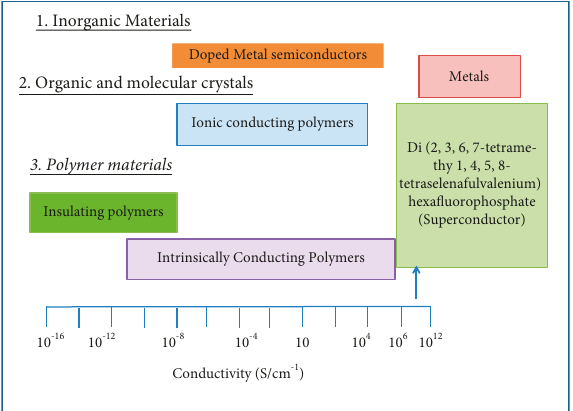
Figure 1: Electrical conductivity of